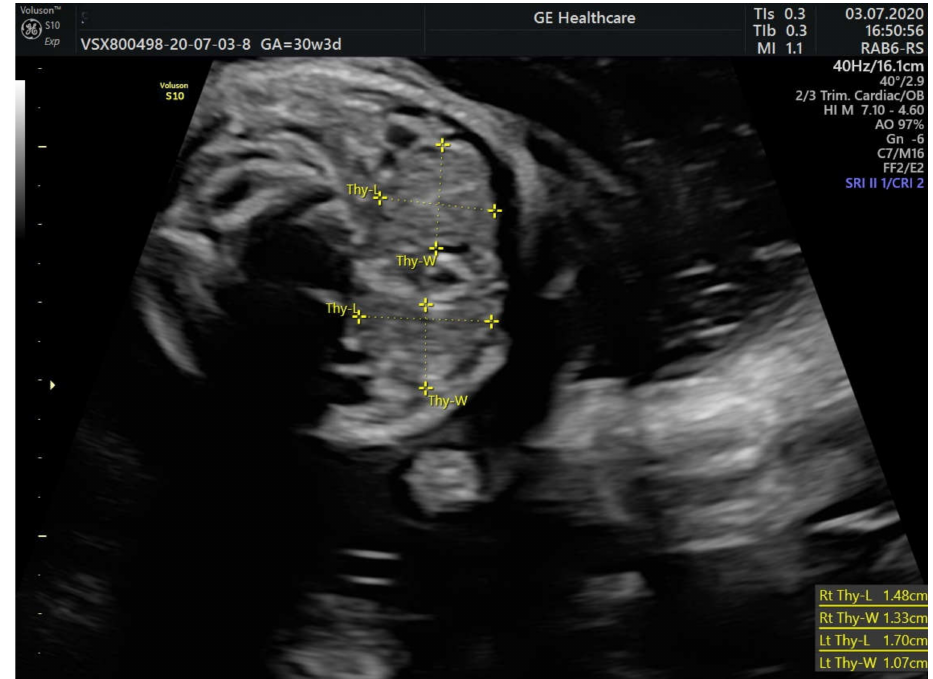
Figure 4. 2-D Ultrasonographic measurements of the fetal thyroid at 30 weeks and 3 days of gestation: right thyroid lobe measures 1.48/1.33 cm and the left thyroid lobe measures 1.70/1.07